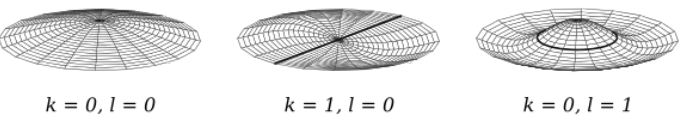
Figure 12. Vibration modes of a membrane fixed at the rim (correlate